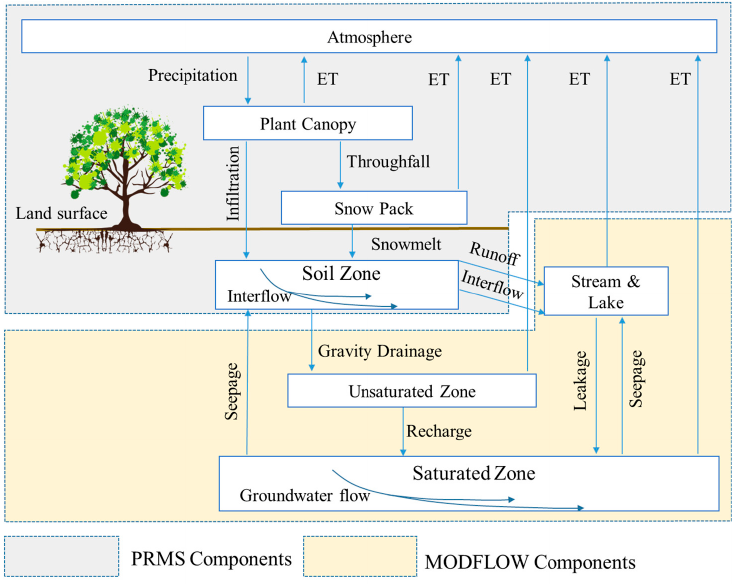
Figure 2. Schematic diagram of